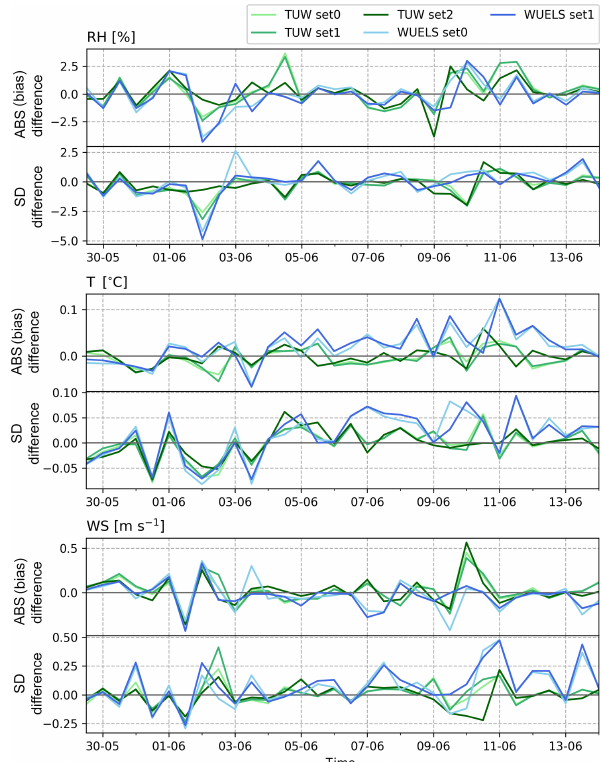
Figure 15. Absolute bias and standard deviation of the differences between statistics of model fed with tomographic data (TUW (set0, set1, set2) and WUELS (set0, set1)) and base forecast for relative humidity (RH), temperature ( T ) and wind speed (WS) 6h after as- similation (12h since model